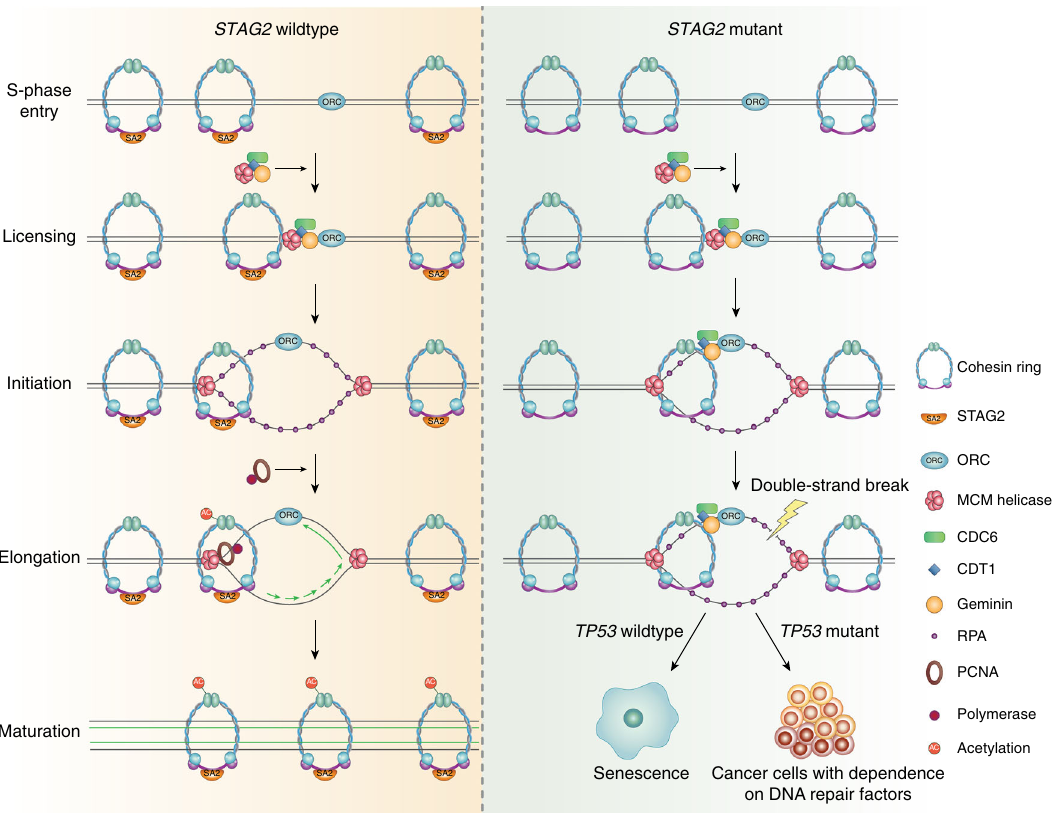
Fig. 9 Model depicting the role of the cohesin complex during replication fork procession. In normal cells with intact STAG2 (left), cohesin dynamically associates with the pre-replication complex and replication machinery to stabilize the replication fork. In cancer cells with STAG2 inactivation (right), disruption of the cohesin interaction with PCNA and DNA polymerases results in failure to establish SMC3 acetylation, replication fork collapse, DNA double-strand breaks, and enhanced sensitivity to DNA damaging chemotherapeutic